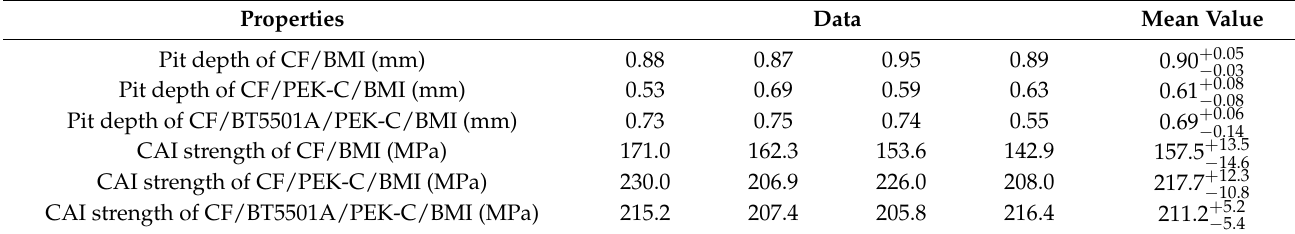
Figure 8. C-scanning images of ( a , b ) CF/BMI composites, ( c , d ) CF/PEK-C/BMI, ( e – h ) CF/BT5501A/PEK-C/BMI. Table 2. Compression after impact (CAI) strength of the composite